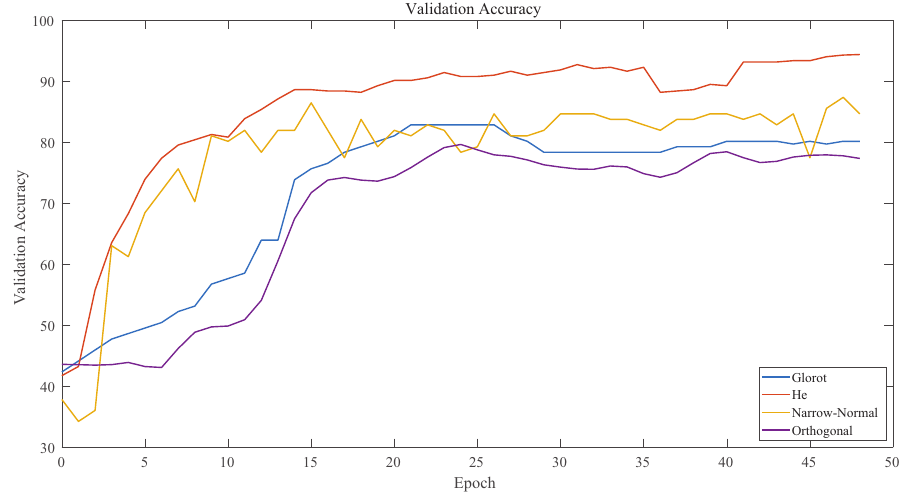
Figure 10. Weight initializer comparison.